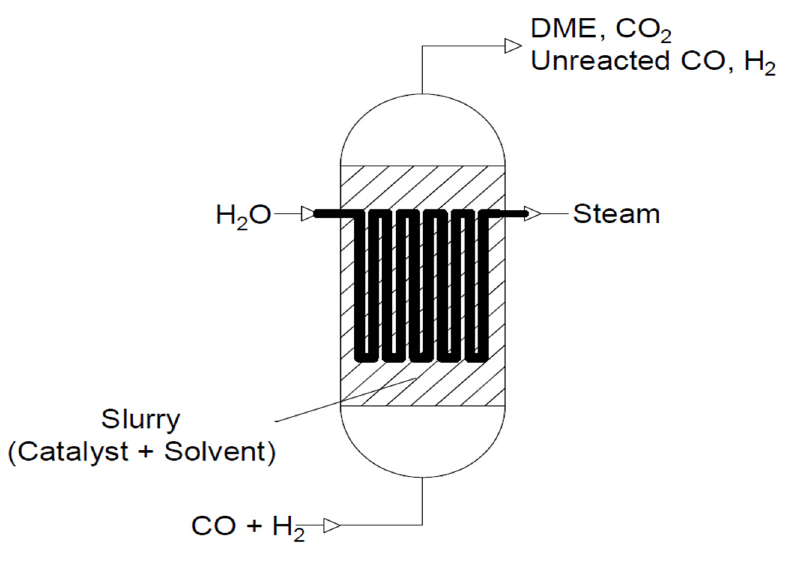
Figure 12. Scheme of a slurry reactor. Developed based on [1].